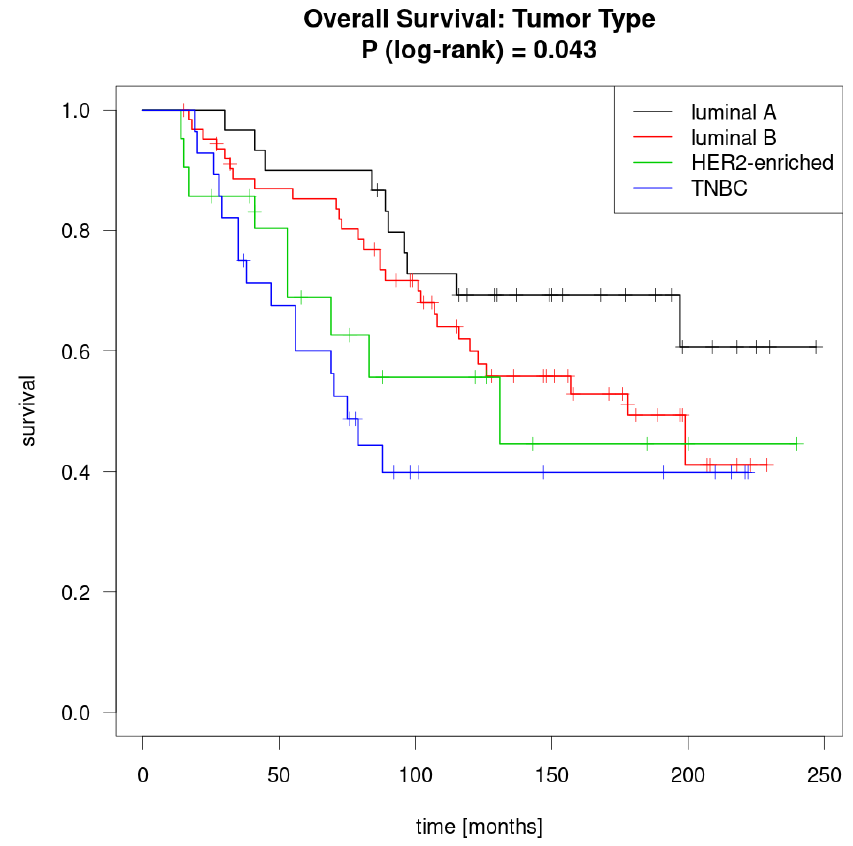
Figure 3. Kaplan-Meier curve for mean survival [months] by tumor subtype.